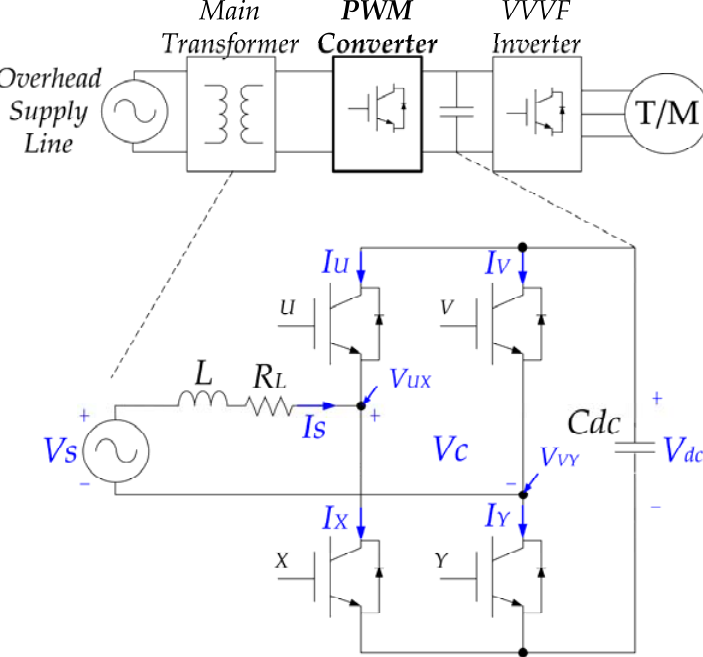
Figure 1. Circuit diagram of conventional single-phase pulse-width modulation (PWM) converter for high-speed railway (HSR) propulsion system.